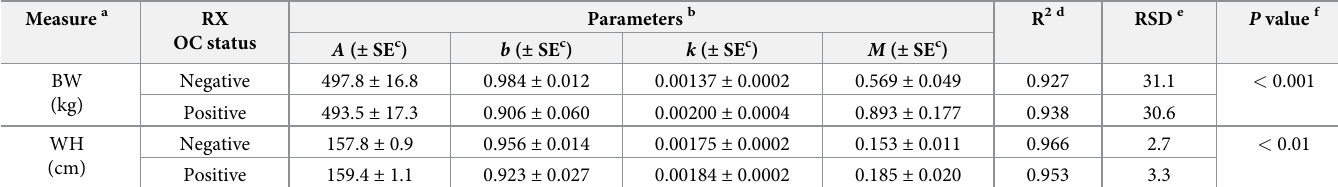
Table 3. Body weight and withers height growth models of Lusitano horses according to radiographic status (negative vs . positive OC) (n = 31).